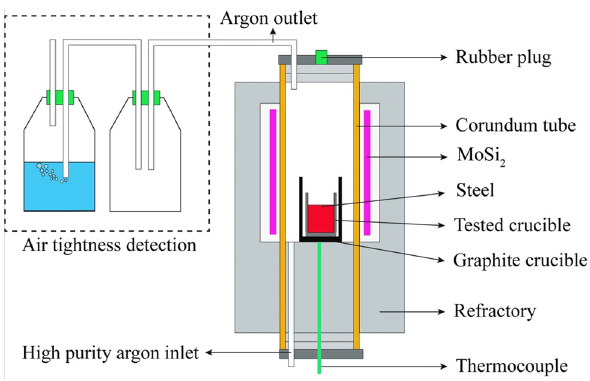
Figure 1: Section diagram of experimental equipment.